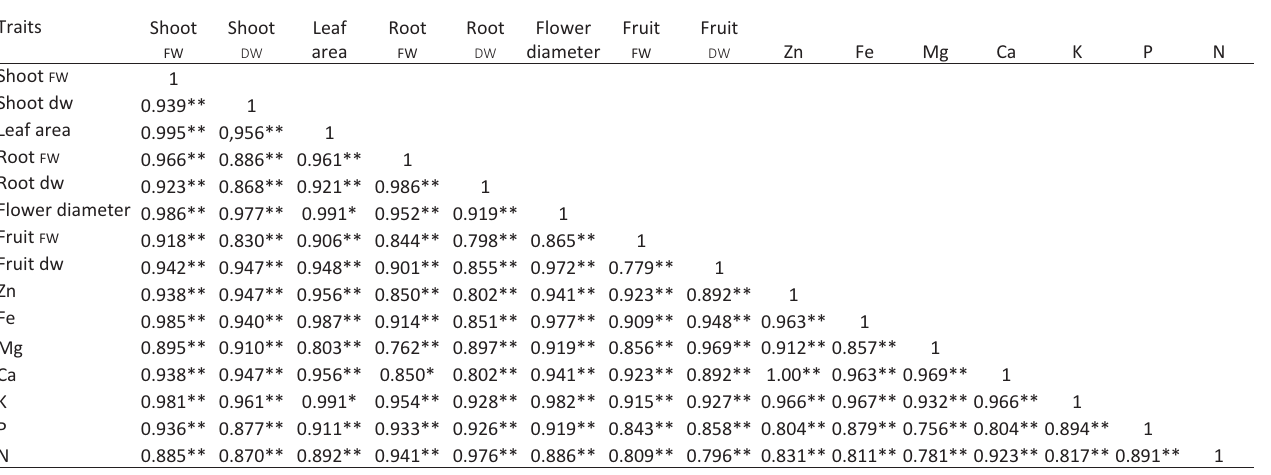
Table 11 - Correlation coefficients for evaluated traits on pot marigold in salinity stress conditions